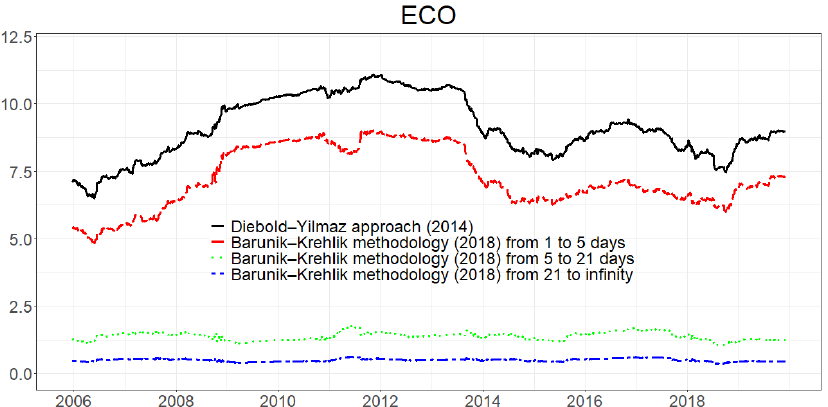
Figure 3. Diebold–Yilmaz [15] directional return spillover (from) and Barunik and Krehlik [16] directional return spillover (from) in the US. Note: ECO indicates the Wilder Hill Clean Energy Index.